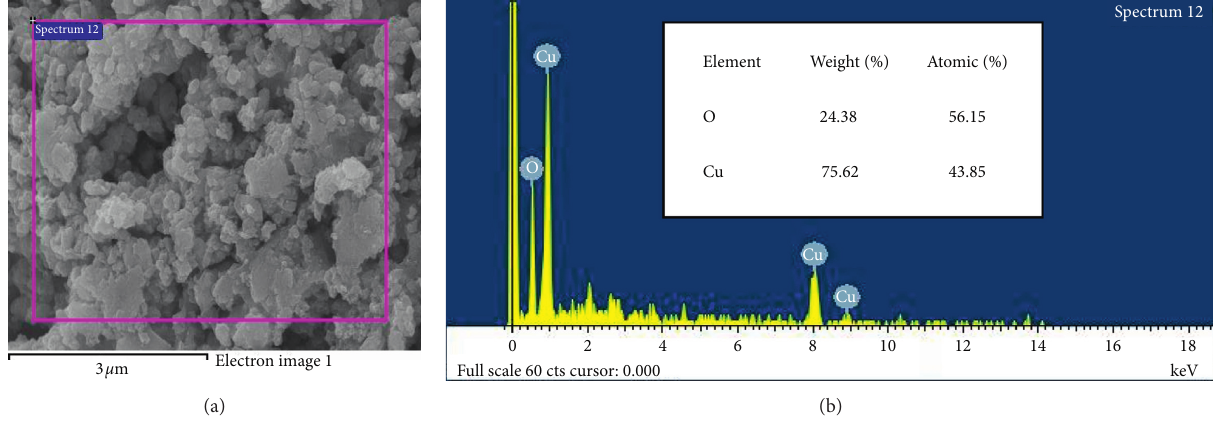
Figure 4: SEM images of the selected area for EDX spectra (a) and quantitative analysis (b) of CuO NPs synthesized using copper (II) nitrate trihydrate and Catha edulis leaf extract in1:10 ratios